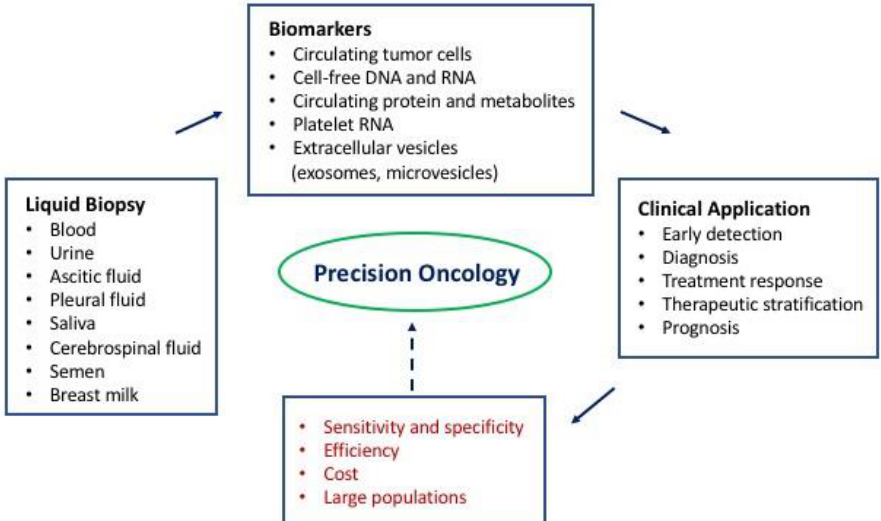
Figure 1. A schematic diagram for liquid biopsy towards precision oncology. Liquid biopsy enables the isolation and identification of molecular biomarkers that facilitate early detection and diagnosis of cancer, as well as monitoring treatment response, stratification of patients for therapy, and assessing prognosis. Further investigation of liquid biopsy is indicated for attaining the goal of precision oncology by (i) improving the sensitivity and specificity of the biomarkers for various clinical applications in patients with cancer, (ii) improving the e ffi ciency and cost of the technologies for isolation and analysis of the biomarkers, and (iii) validating the accuracy of the biomarkers in prospective studies with large populations.